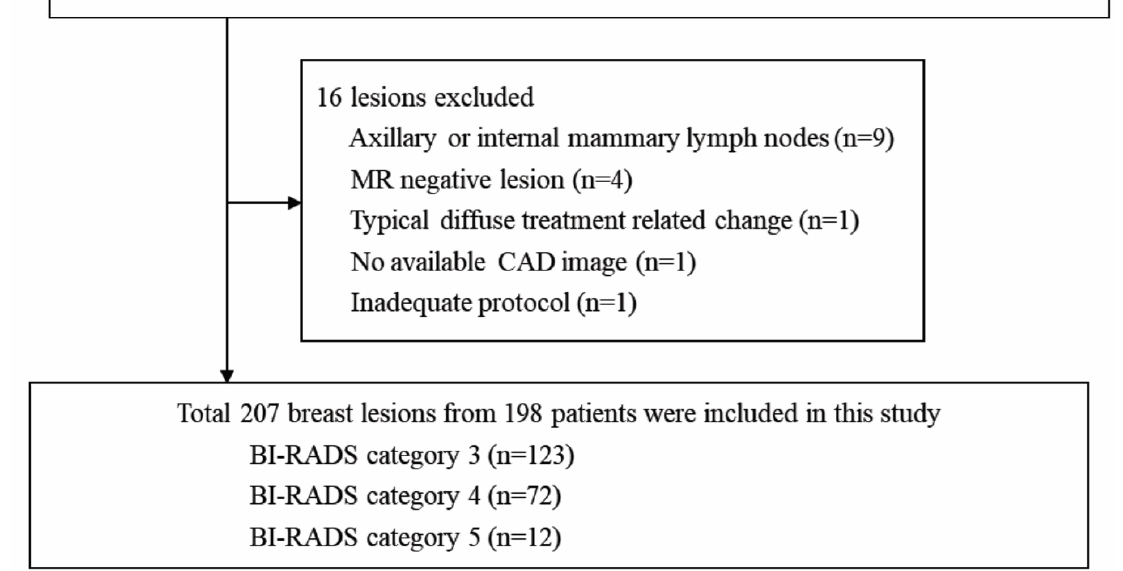
Figure 1. Flowchart of the study population and exclusion criteria. AB-MRI = abbreviated breast MRI, BI-RADS = Breast Imaging Reporting and Data System, CAD = computer-assisted diagnosis.